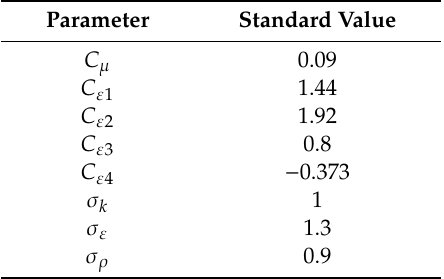
Table 2. Standard values of the parameters of the k- ε